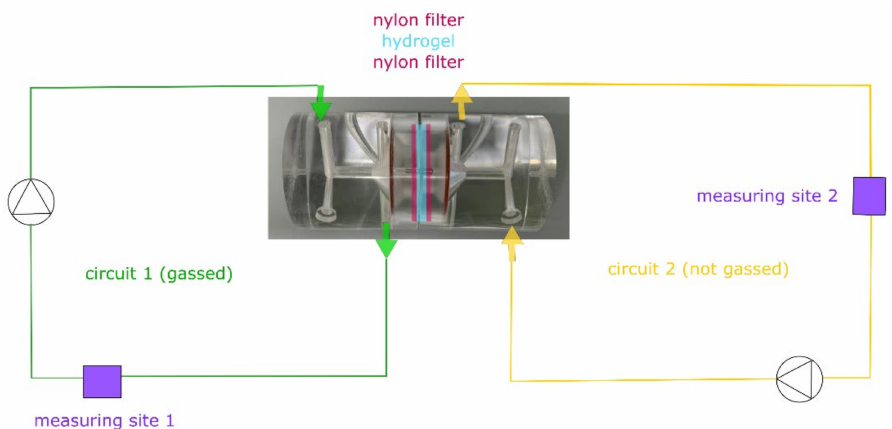
Figure 1. Schematic experimental setup for oxygen diffusion experiments using gassed and non- gassed circuits separated by a nylon filter (membrane) hydrogel sandwich and equipped with optical oxygen measuring